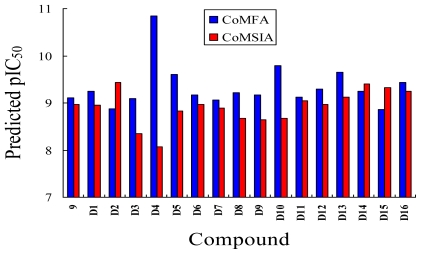
Graph of the predicted pIC50 values of the designed inhibitors using CoMFA and CoMSIA.